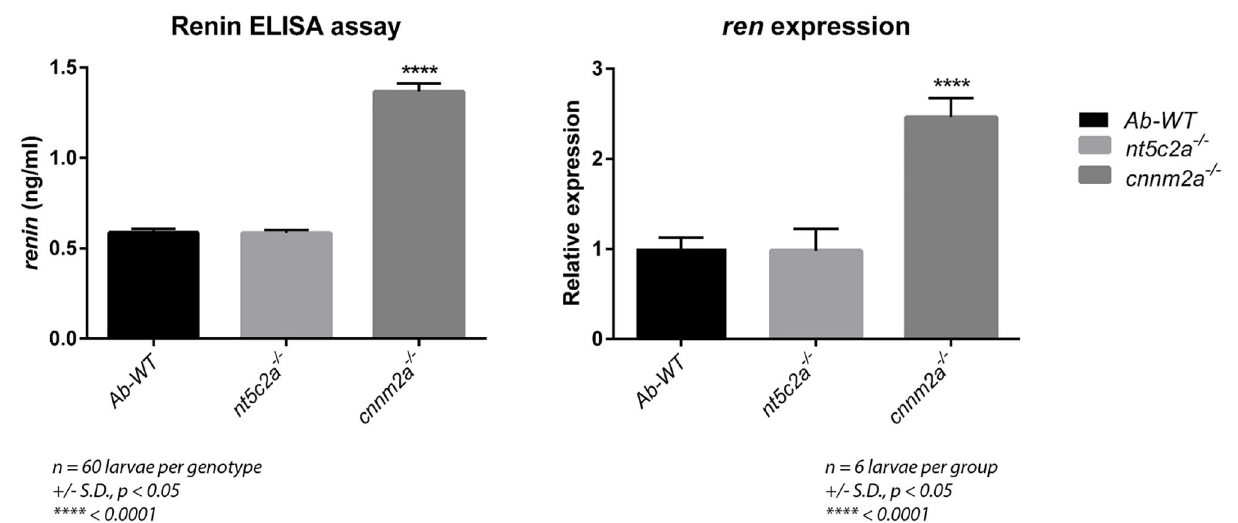
FIGURE 9 | Graph on the left presents the renin levels (ng/ml) measured using ELISA assay from ab-wildtypes, nt5c2a and cnnm2a zebrafish mutant larvae. Assay was performed with six groups per genotype with n = 10 larvae per group ( n = 60 larvae per genotype). Graph on the right presents relative expression of ren gene in